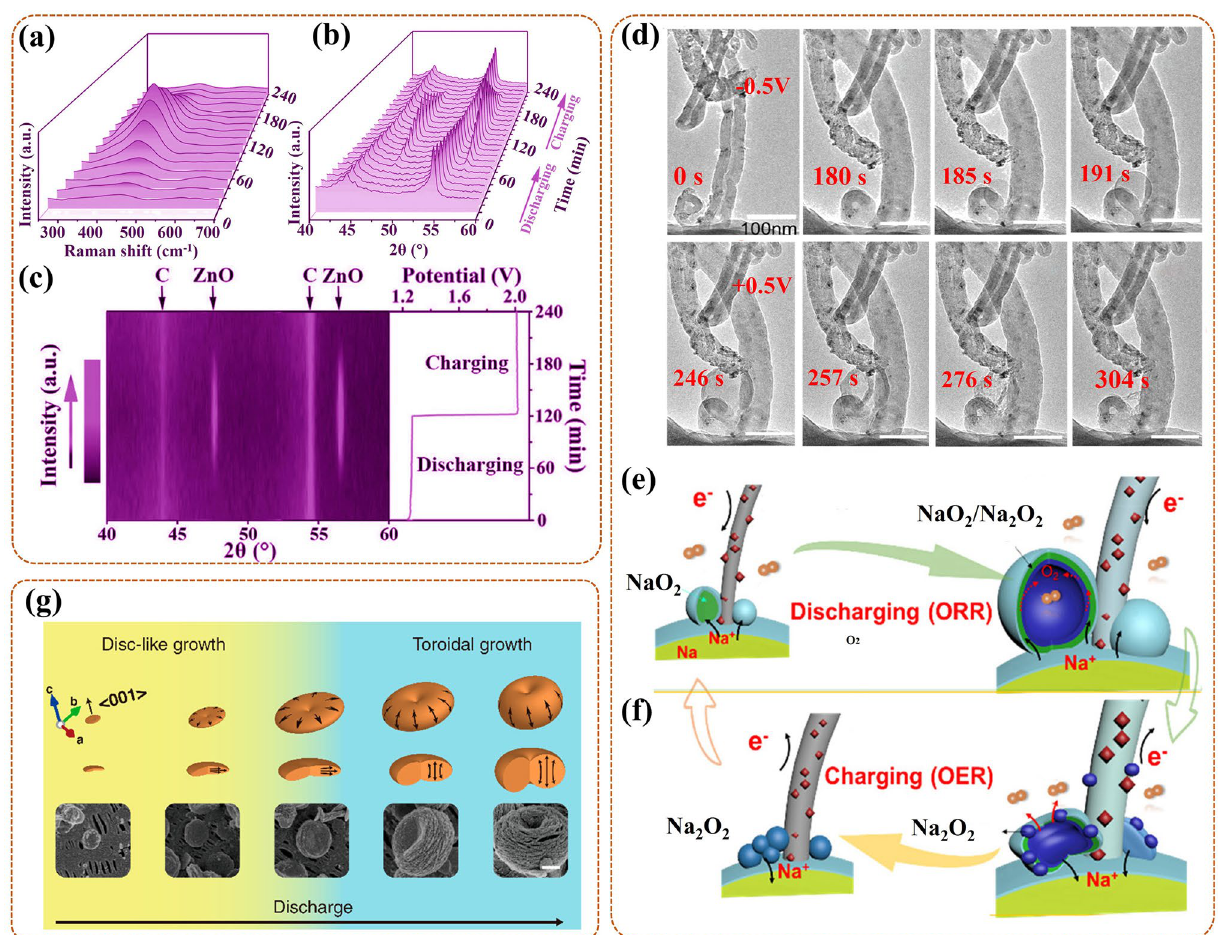
Fig. 11 a In-situ Raman spectrum, b in-situ XRD pattern, c the in-situ XRD intensity map of Meso-CoNC@ GF during discharging (i.e., ORR) and charging in Zn–Air battery [81]; Reused with approval; Copyright 2017 WILEY-VCH Verlag GmbH & Co. KGaA, Weinheim. d In-situ TEM images of the product on the Pt 0.8 Ir 0.2 @CNT surface, at 0–191 s during discharge (ORR), and at 246–304 s during charging in Na-O 2 bat- tery, with schematics of e ORR process and f OER process [133]. Reused with approval; Copyright 2019 American Chemical Society. g Growth mechanism schematics of the product in the electrolyte (upper part), and the corresponding SEM image (bottom part), with DBBQ as catalyst, in the